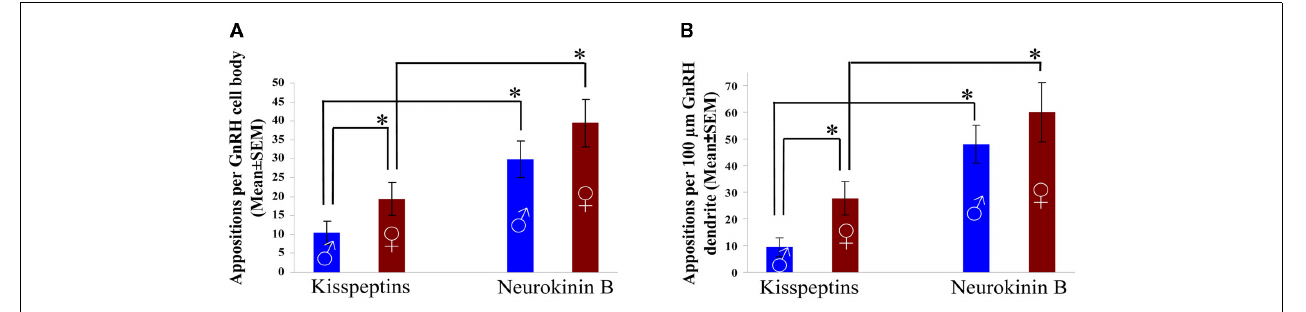
(A) and dendrites (B) . Note that the number of preproNKB-IR contacts is significantly higher than the number of kisspeptin-IR contacts on both the somatic (A) and the dendritic (B) membranes and in both males and females.The kisspeptin-IR input to GnRH cell bodies (A) and dendrites (B) is highly sexually dimorphic.The mean incidence of kisspeptin-IR contacts is 88.2% higher on GnRH-IR cell bodies and 177.4% higher on GnRH-IR dendrites in postmenopausal females vs. aged males. In contrast, there is no statistical difference between the two sexes in the incidences of preproNKB-IR contacts, although the means are somewhat higher in females. ∗ P <